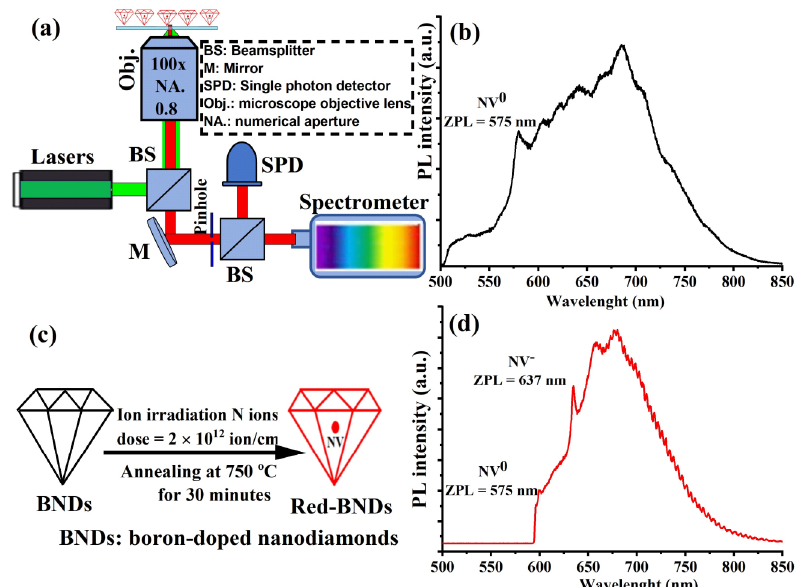
Figure 2. ( a ) An illustration of a custom-made confocal microscope designed and equipped with green and NIR lasers for optical quantum sensing measurements of boron-doped nanodiamonds (BNDs). ( b ) Photoluminescence optical spectrum of BNDs before irradiation. The PL spectrum shows a weak intrinsic NV center spectrum where the negatively charged (NV − ) center is partially quenched by the presence of boron atoms. ( c ) An illustration of converting boron-doped nanodiamonds (BNDs) to more fluorescent BNDs after nitrogen implantation and annealing. ( d ) The NV spectrum in the irradiated BNDs shows much weaker neutrally charged (NV 0 ) center compared to NV − because the implanted nitrogen creates substitutional nitrogen (P1) centers, which act as donors, bringing up the Fermi level of the BNDs enough to make the NV − charge state stable and dominant. The NV − showed a clear PL spectrum with zero-phonon lines (ZPL) of NV0 and NV- peaked at 575 nm and 637 nm,